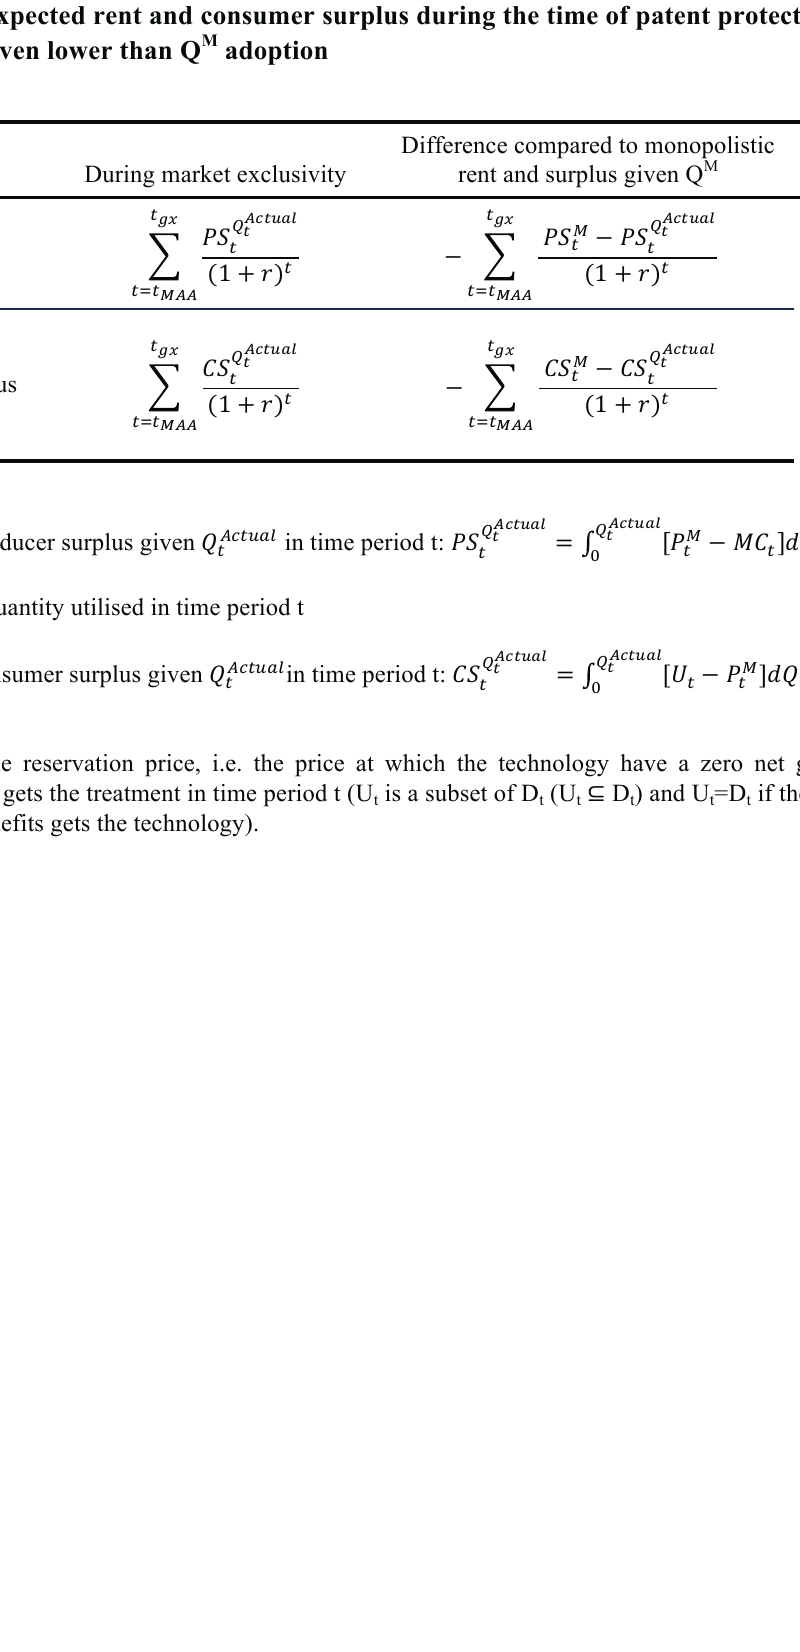
Table A4: Expected rent and consumer surplus during the time of patent protection given lower than Q M adoption